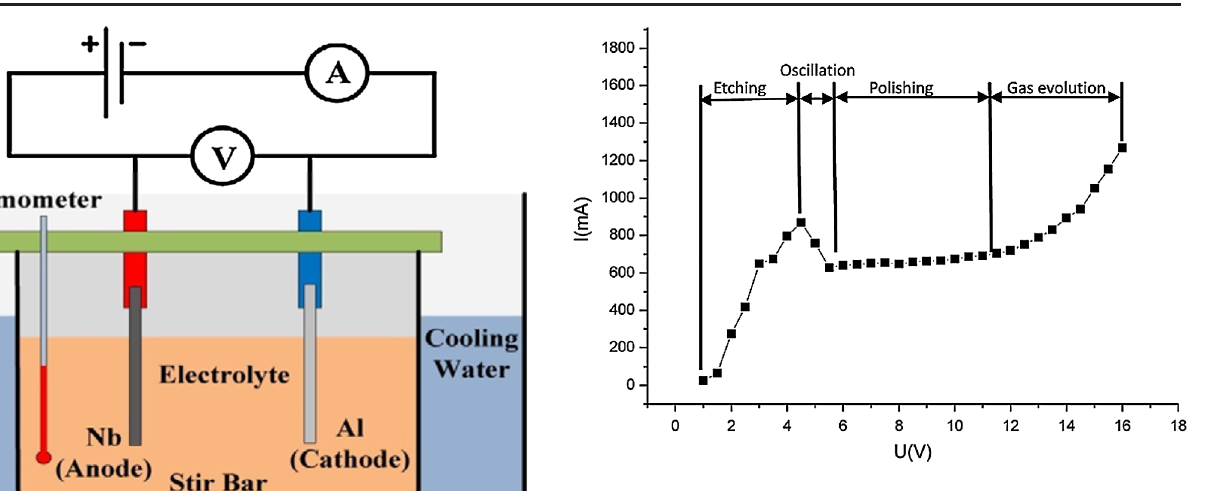
FIG. 2. The typical I-V curve for buffered electropolishing.